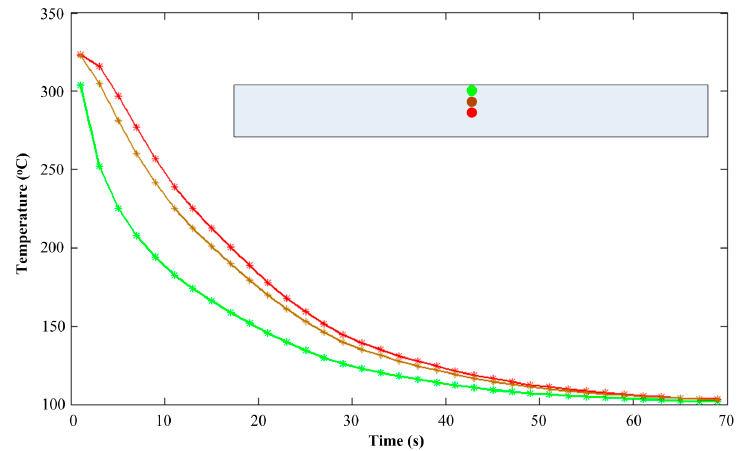
Figure 4. Cooling profiles of material elements at the center cross-section.